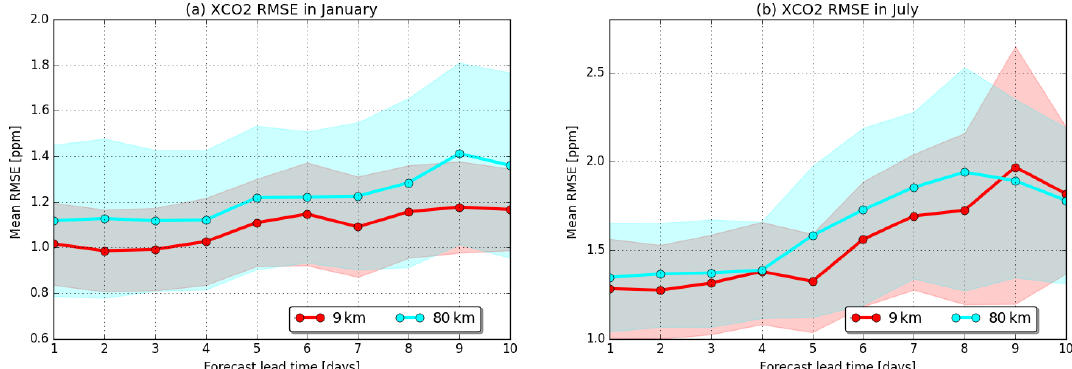
Figure 10. Same as Fig. 9 but for XCO 2 (ppm). The errors are computed with respect to hourly TCCON observations from 18 TCCON stations (see Table A3).